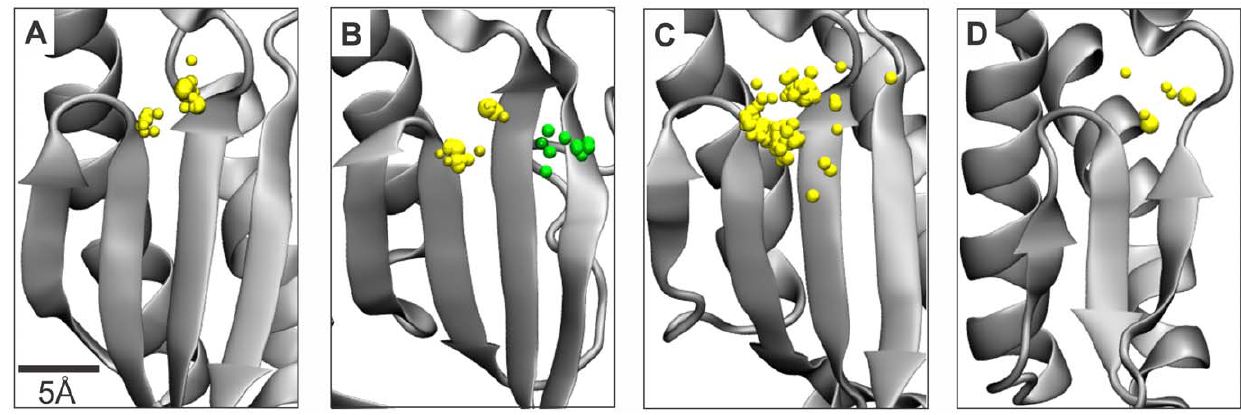
Figure 4. Positions of cations in the palm domain of hand-shaped DNA-dependent polymerases. The yellow spheres indicate catalytic ions, and the green spheres indicate cations that are positionally distinct from the catalytic cations. Structural alignments of (A) A family DdDps, (B) B family DdDps, (C) Y family DdDps, and (D) DdRps. The aligned cations are depicted with the polypeptide chain of the catalytic region from (A) Bacillus stearothermophilus DdDp (PDBid: 2BDP), (B) bacillus phage w 29 DdDp (PDBid: 2PYJ), (C) human DNA polymerase k (PDBid: 2OH2), and (D) enterobacteria phage T7 DdRp (PDBid: 1S76).